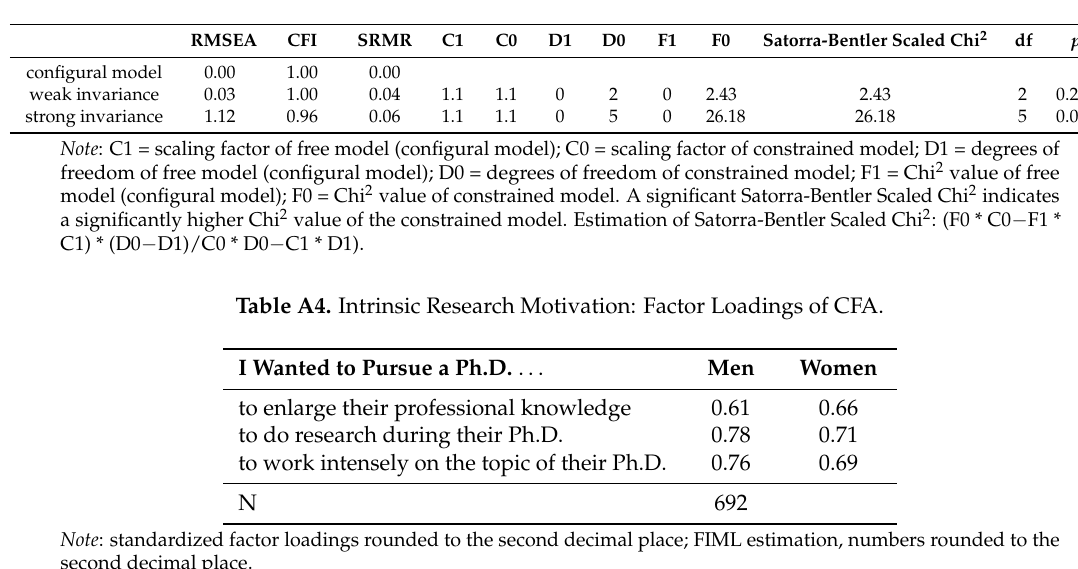
Table A3. Measurement Invariance of Academic Career Intentions.